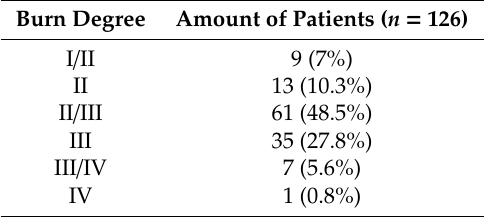
Table 1. Burn degree among patients enrolled in the